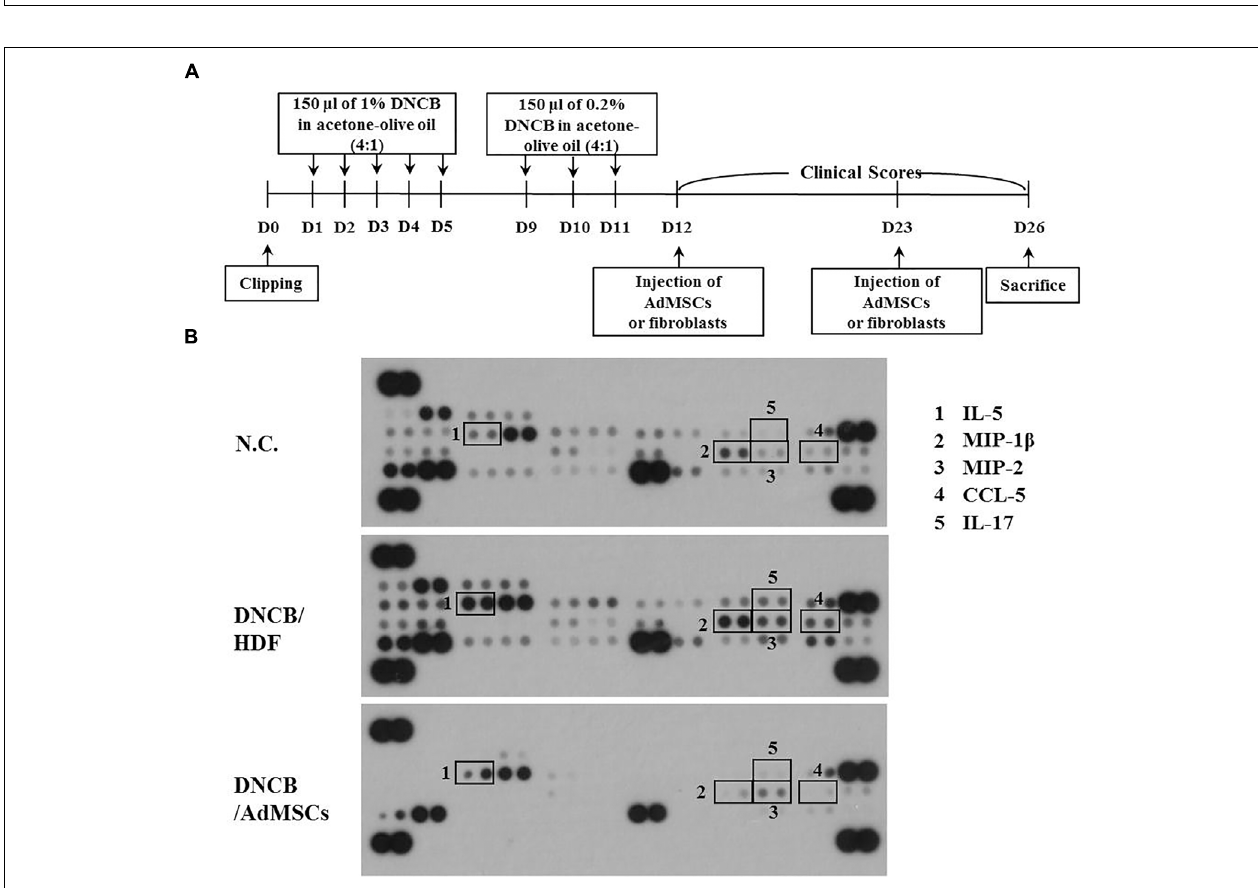
FIGURE 3 | Identification of cytokines subjected to opposite regulations by AD and AdMSCs. (A) Shows the experimental time line to determine cytokines that mediate AD and serve as targets of AdMSCs. (B) Serum of BALB/c mouse of each experimental group was subjected to cytokine array analysis. Serum was obtained at the time of